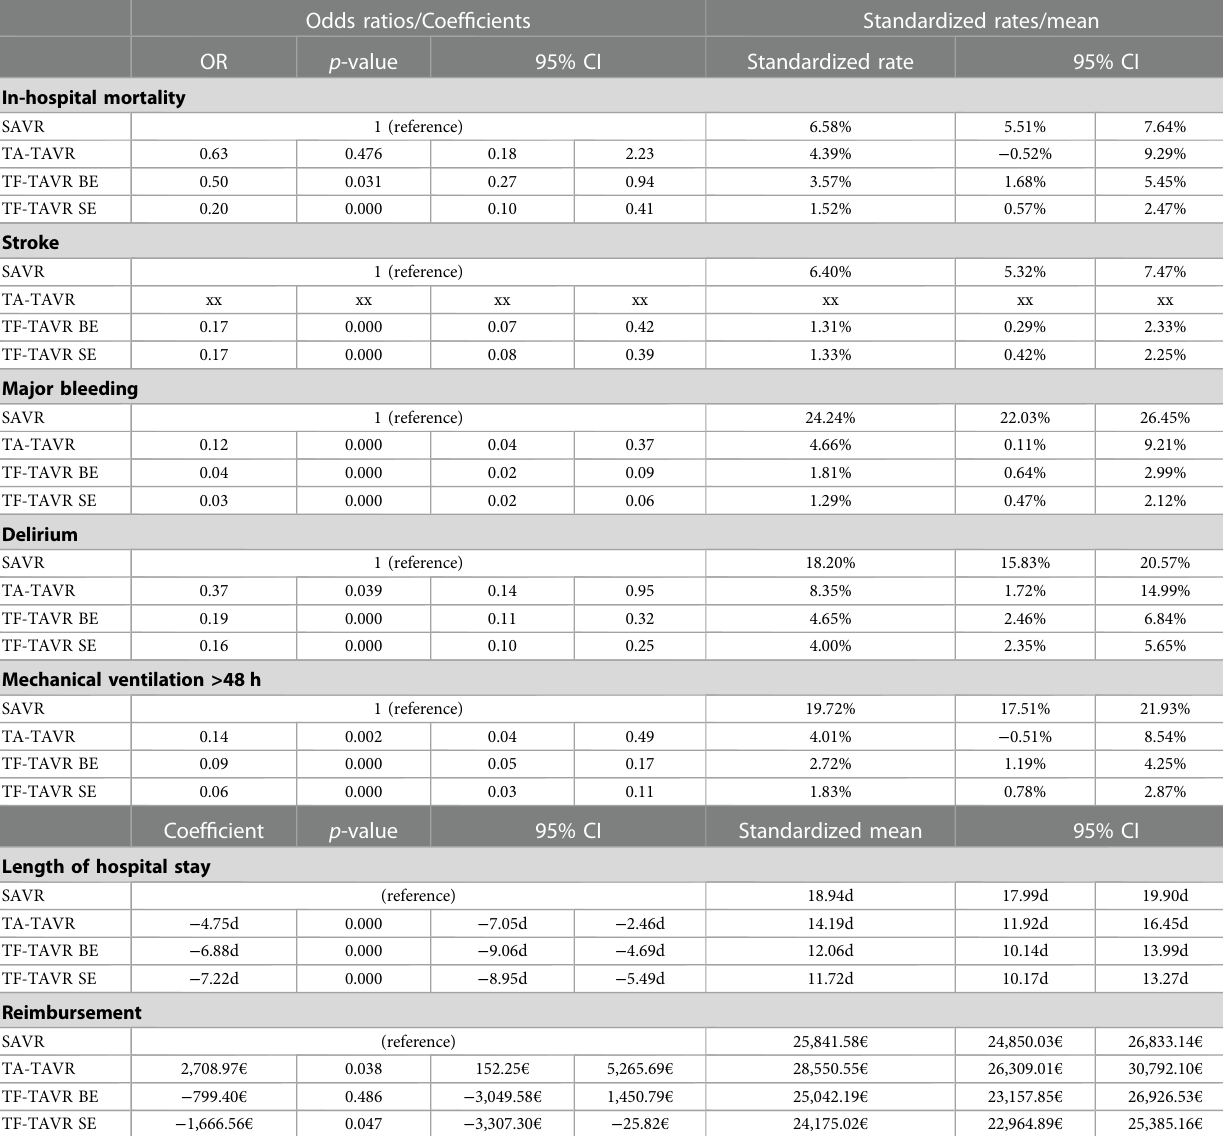
TABLE 3: Regression results of in-hospital outcomes of patients treated for aortic regurgitation between 2018 and 2020. Odds ratios/Coef fi